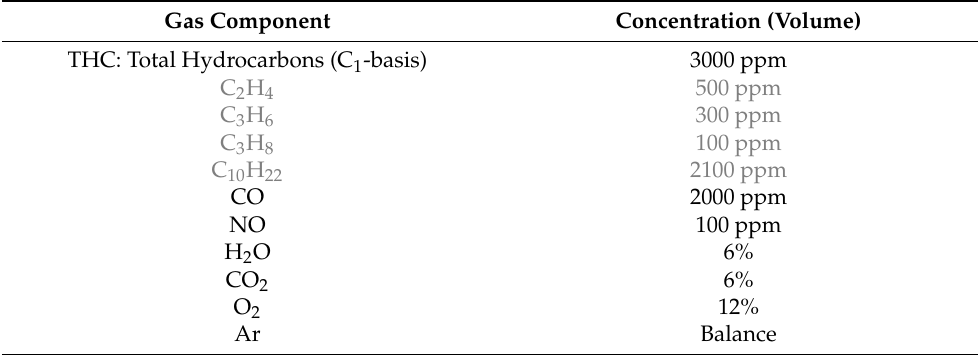
Table 4. Low-Temperature Combustion-Diesel (LTC-D) exhaust constituents and concentrations. Gas Component Concentration (Volume) THC: Total Hydrocarbons (C 1 -basis)